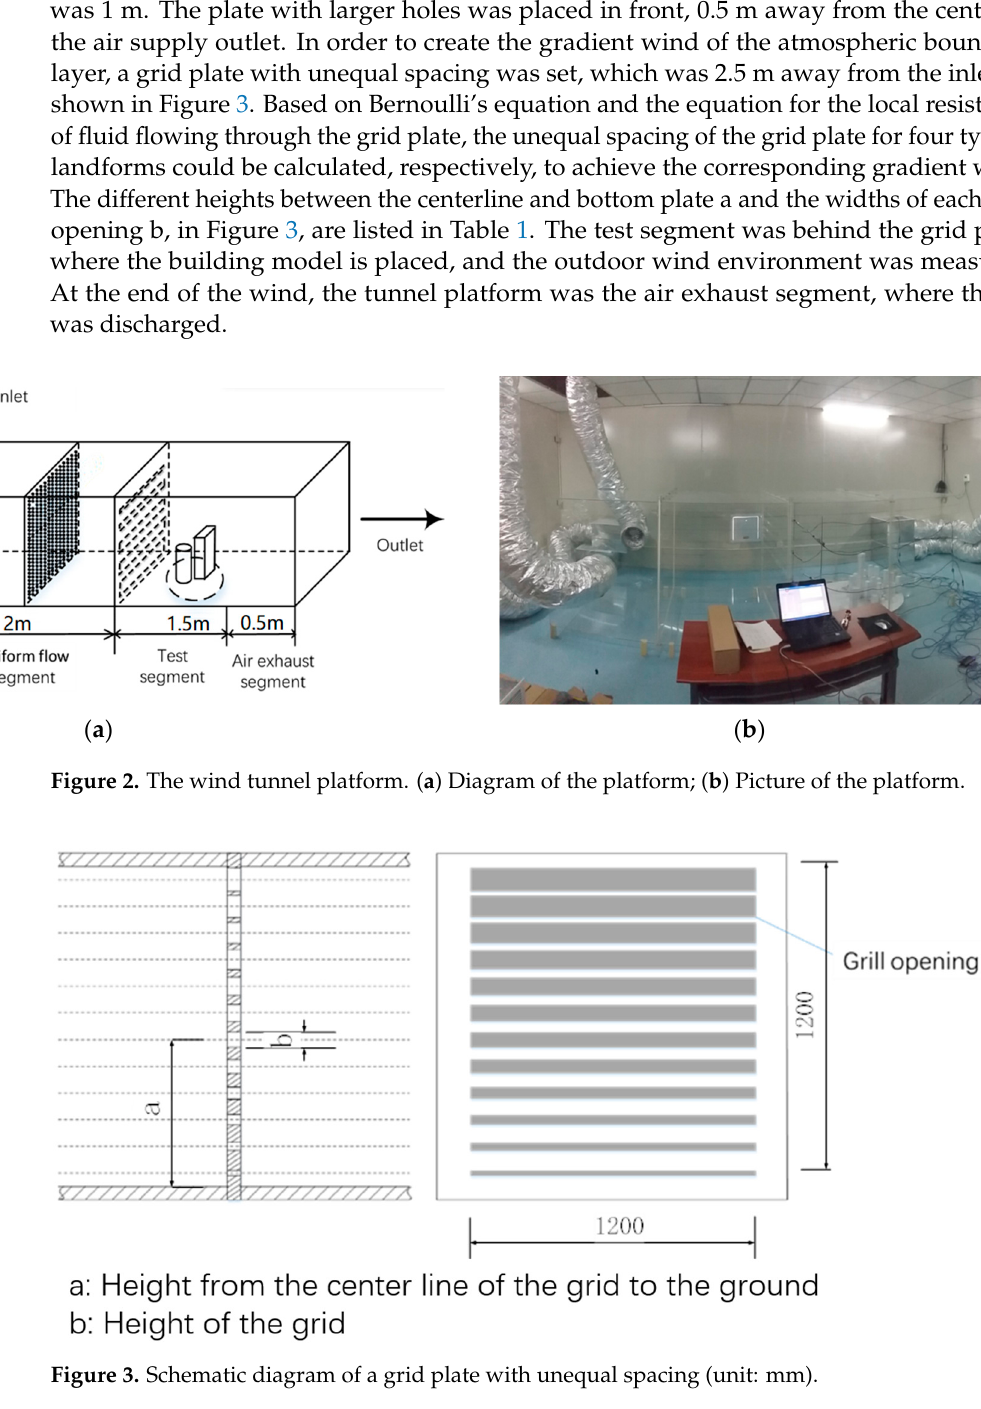
Figure 2. The wind tunnel platform. ( a ) Diagram of the platform; ( b ) Picture of the platform.